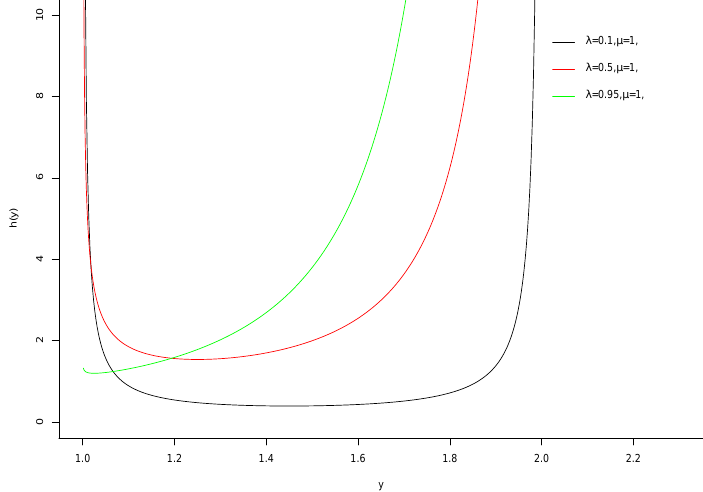
Figure 2. The hazard rate functions of two parameter RK distribution for various parameter